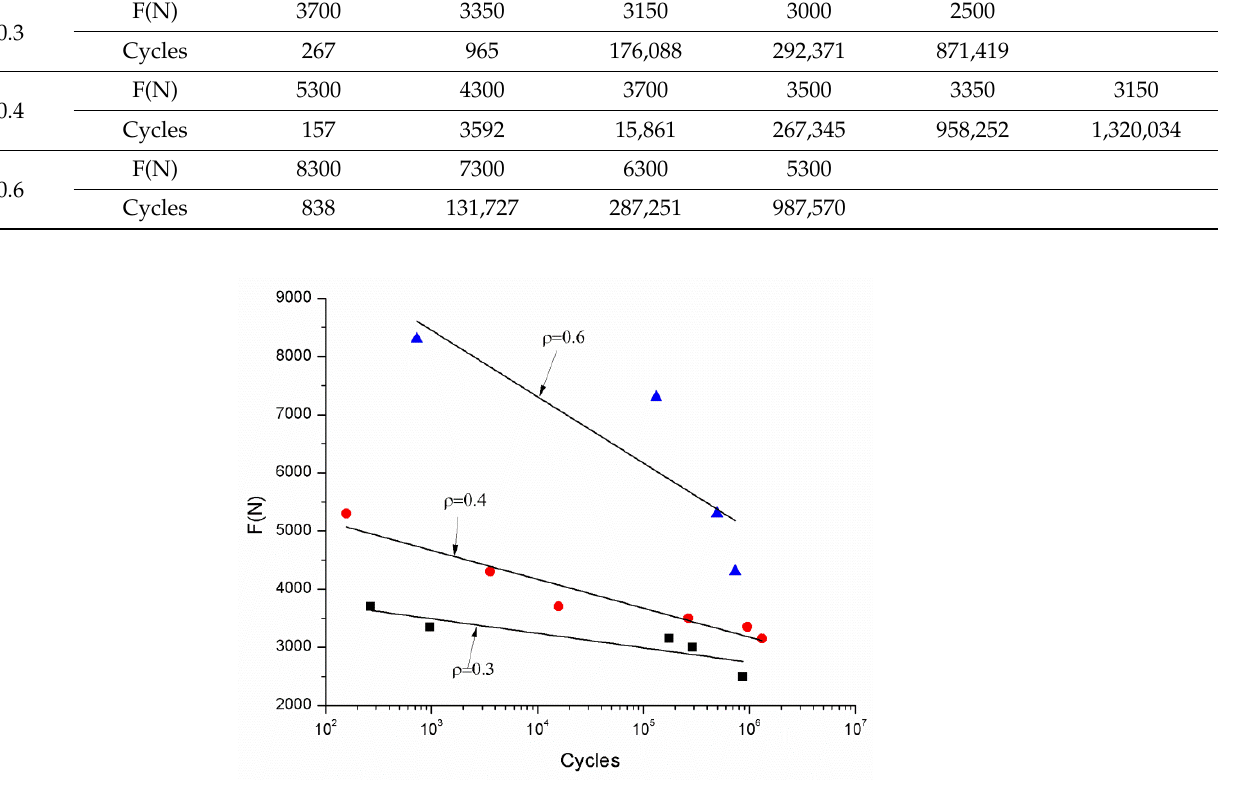
Figure 3. Force cycle curves for the aluminum foam sandwiches in the three-point bending tests. The criterion for curve fitting uses the nonlinear curve